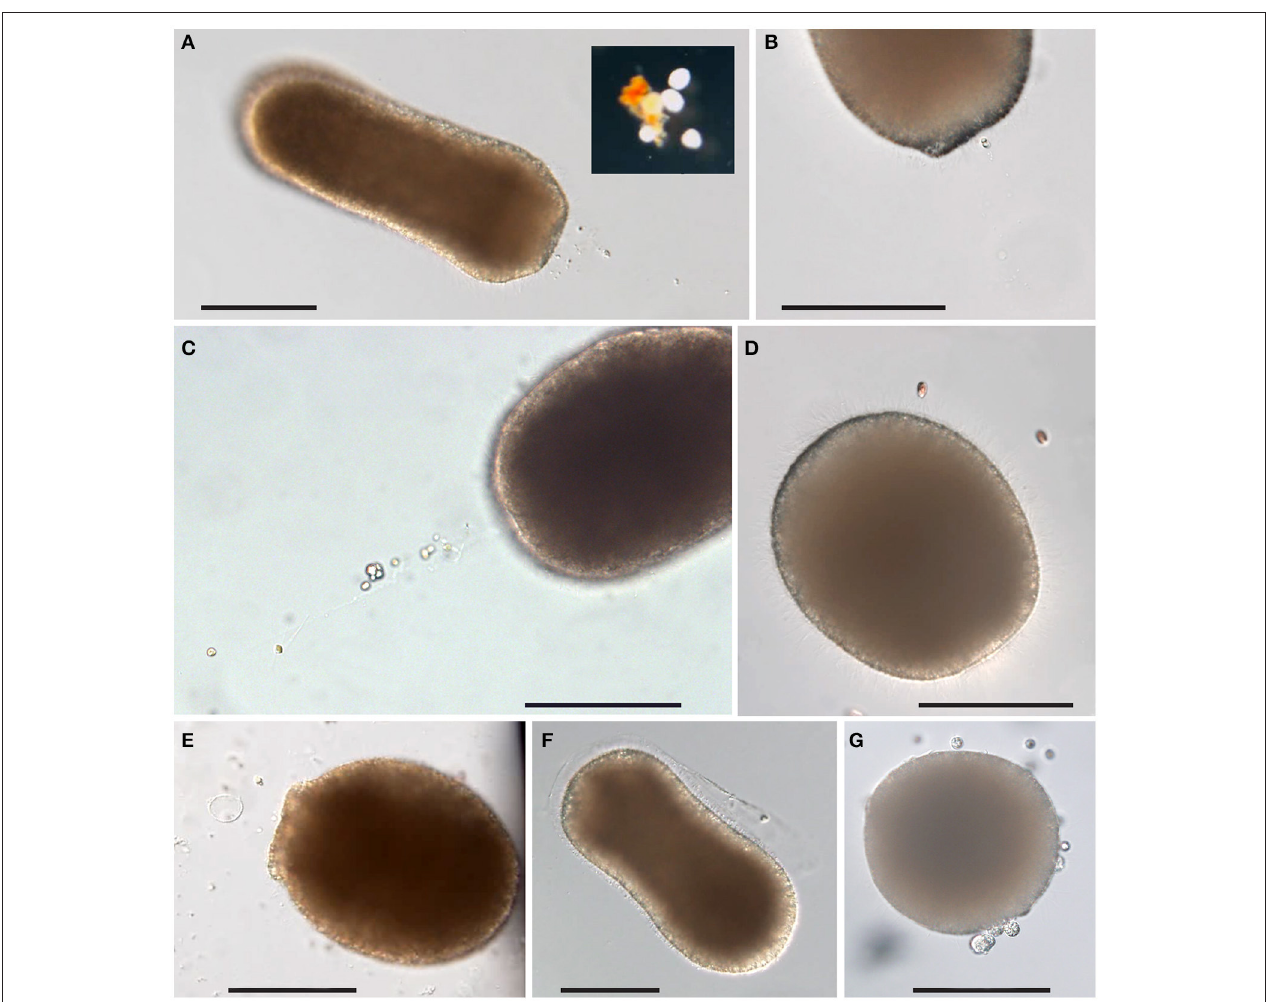
FIGURE 5 | Response of L. pertusa planulae to food treatments. (A) Mucus string in response to copepod homogenate. Inset: a cluster of planulae attached to larger particles of copepod tissues. (B) Mucus string with adhering picoplankton. (C) Mucus string with adhering microalgae ( Isochrysis sp.). (D) Larger size microalgae ( Rhodomonas sp.) in contact with planula close to the aboral end. (E) A planula with extended mouth in response to fish blood. (F) A planula is shedding a sheet of mucus after exposure to fish blood. (G) Planula infested with parasites. Scale bars 100 µ